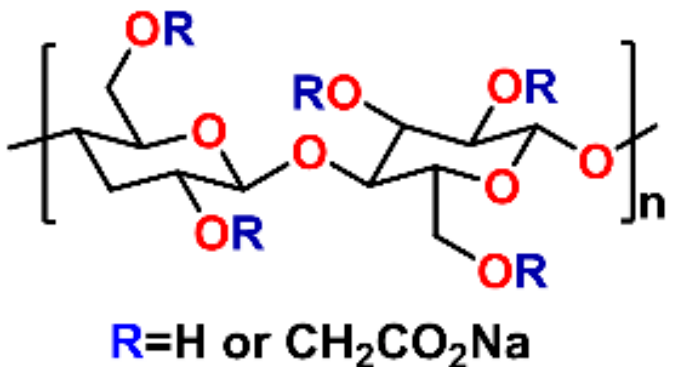
Figure 1. Chemical structure of carboxymethylcellulose [3].